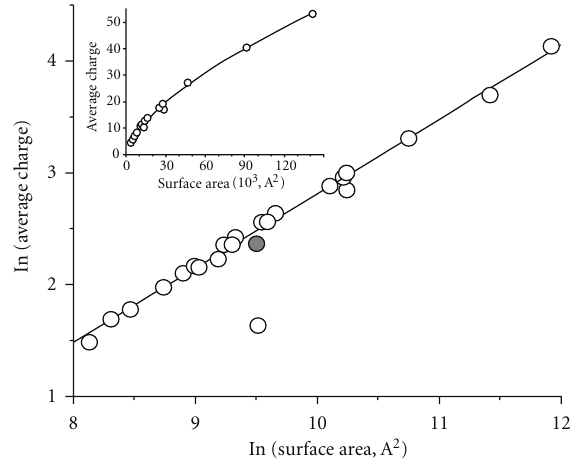
Figure 12: Correlation between the average charge state of protein ions generated by ESI under near-native conditions (10mM ammo- nium acetate, pH adjusted to 7) and their surface areas in solution, whose calculation was based upon their crystal structures. The data are plotted in the logarithmic scale (a graph plotted in the normal scale is shown in the inset). A gray-shaded dot represents a pepsin data point. An open circle underneath represents the highest charge of pepsin if the extent of multiple charging was limited by the number of basic residues within the protein molecule. (Reprinted with permission from Analytical Chemistry [77], Copyright 2005, American Chemical Society).